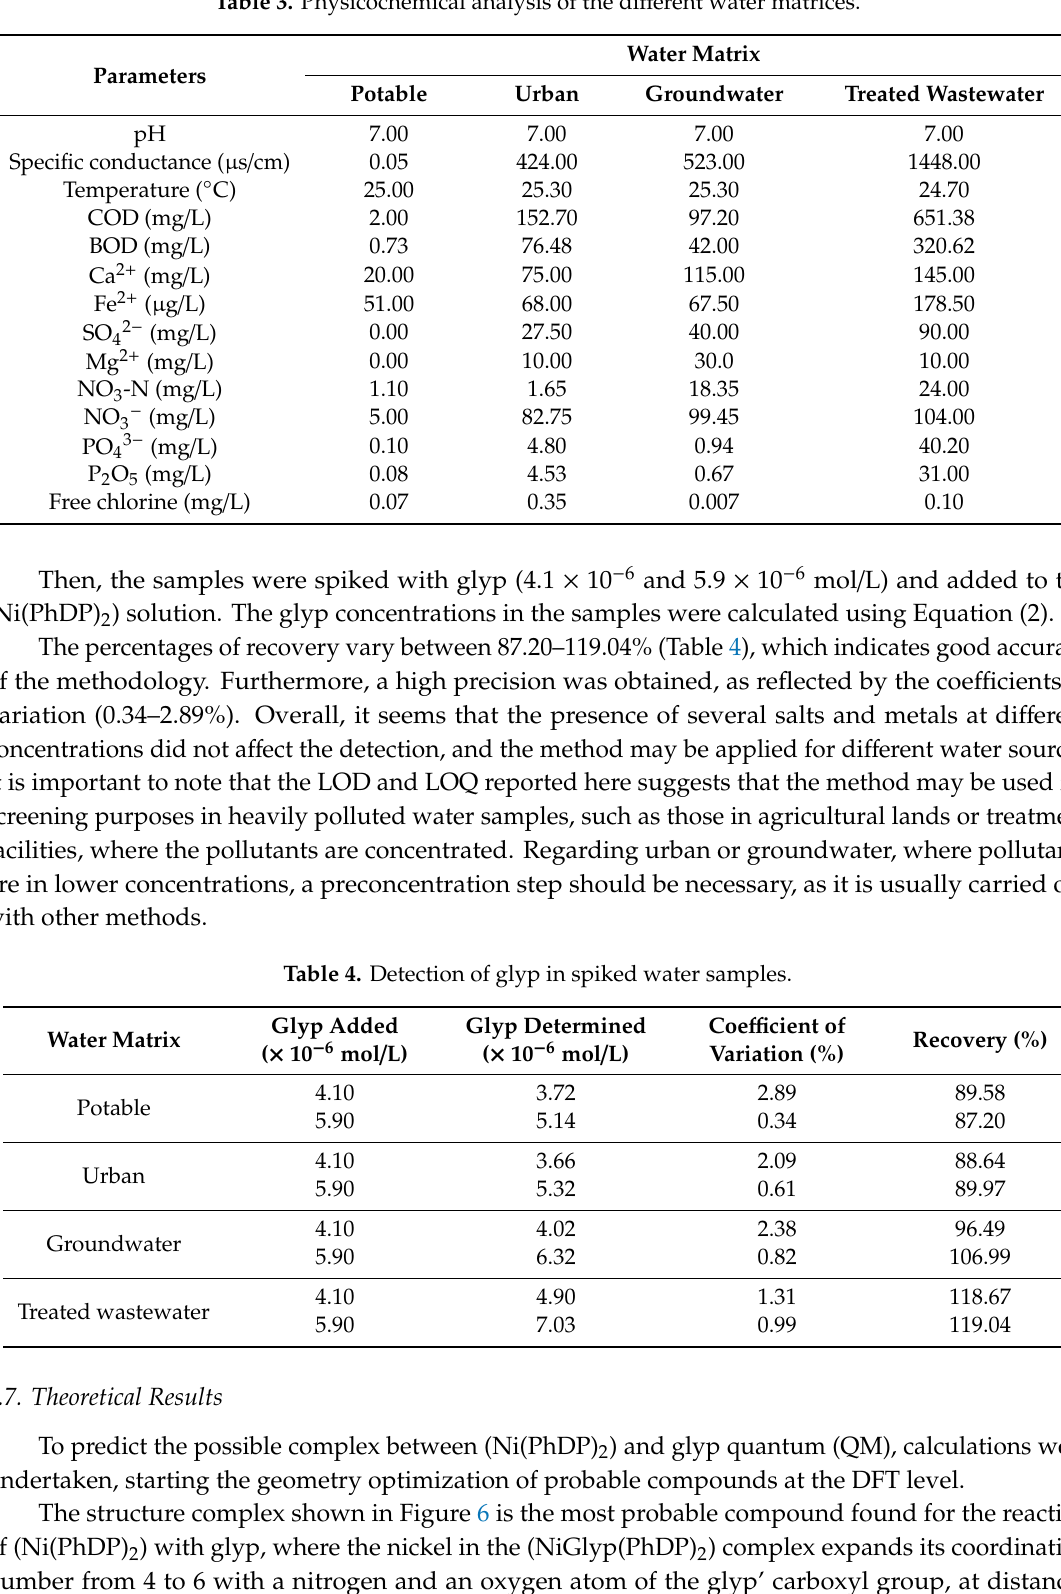
Table 3. Physicochemical analysis of the di ff erent water matrices.